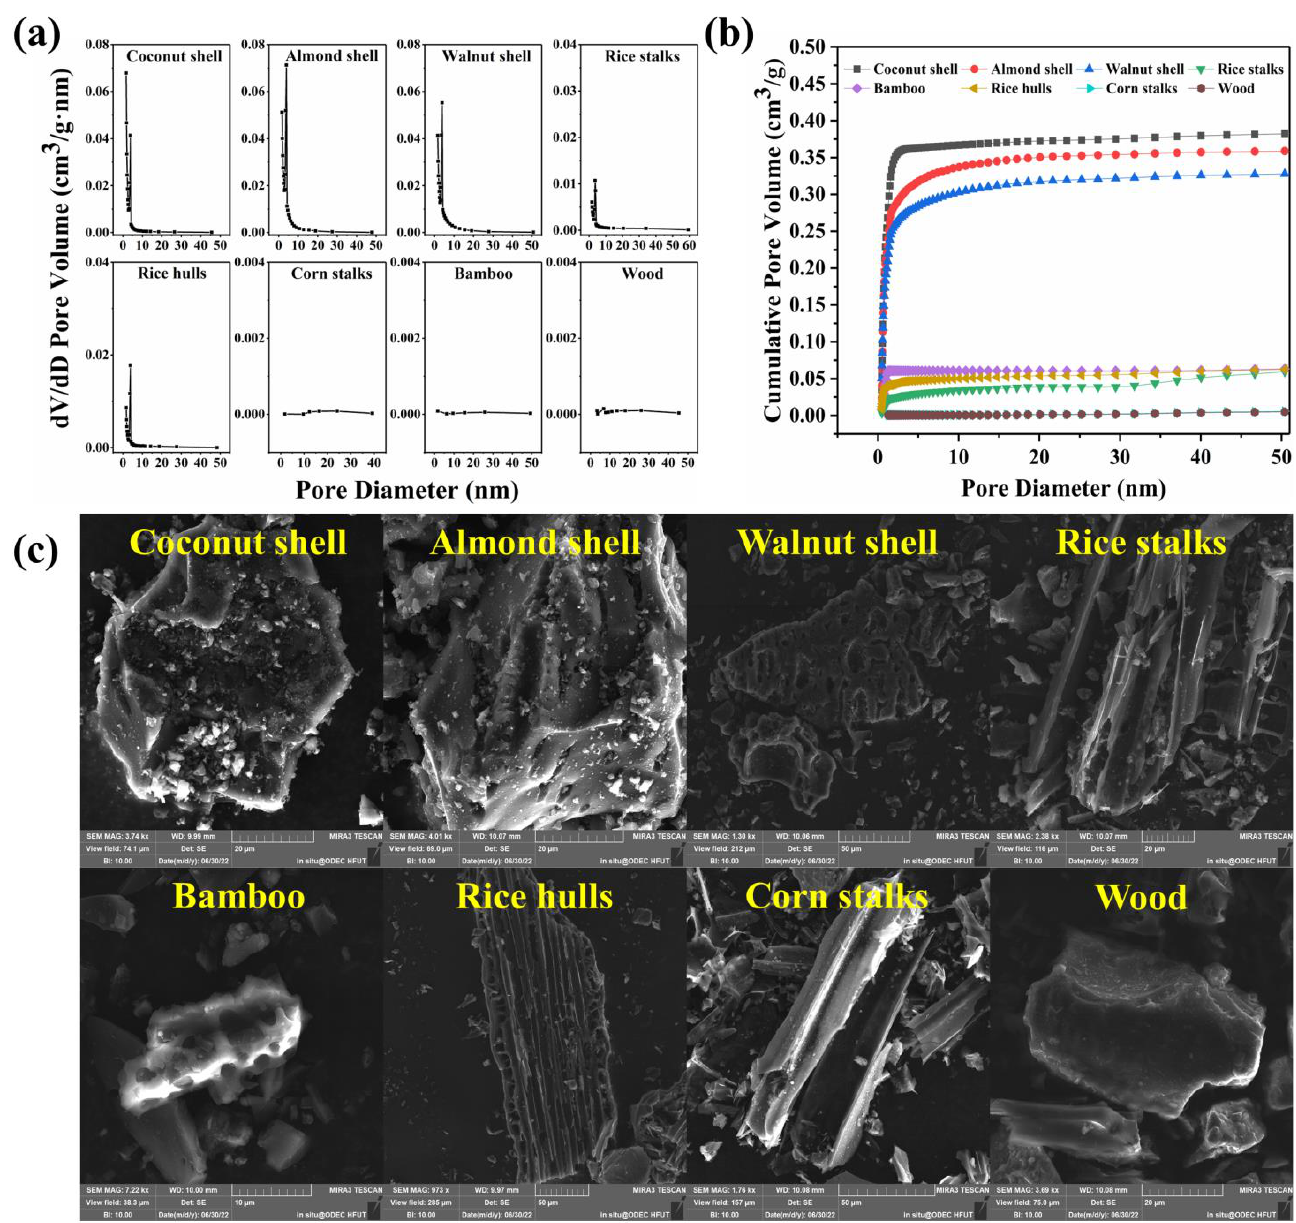
Figure 1. ( a ) Pore diameter distribution; ( b ) pore diameter – pore volume relationship; ( c ) SEM of biochars.